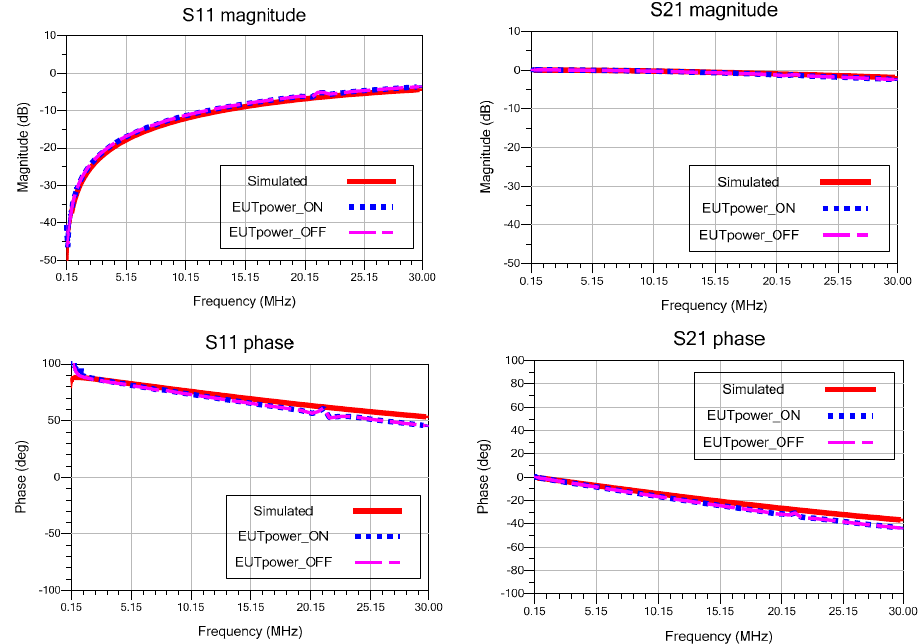
Figure 10. Comparison of the S-parameters obtained by simulations (red), EUT not powered (pink), and EUT powered (blue) for the Boost Converter Model MCP1640EV-SBC.